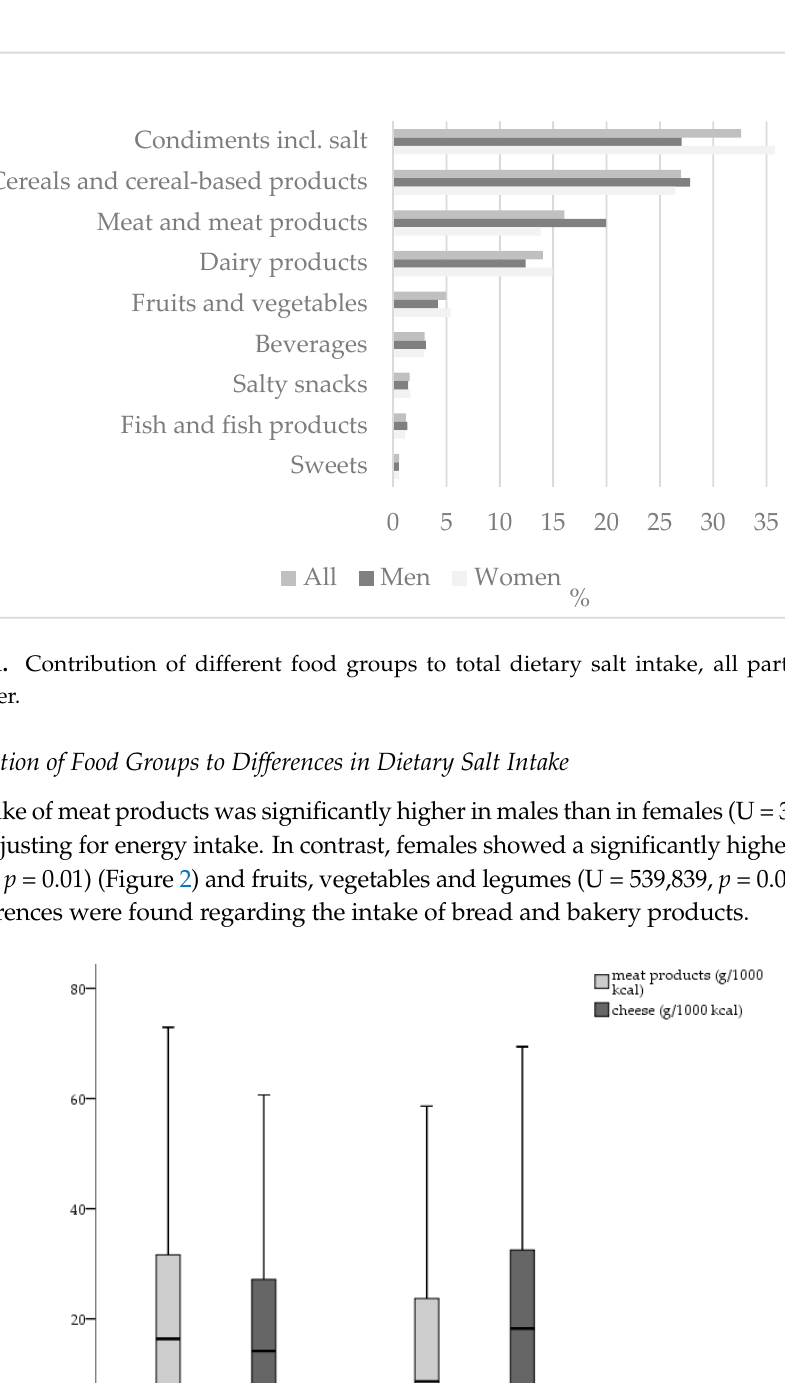
Figure 3. Daily intake of meat products (g/1000 kcal) by BMI-groups.